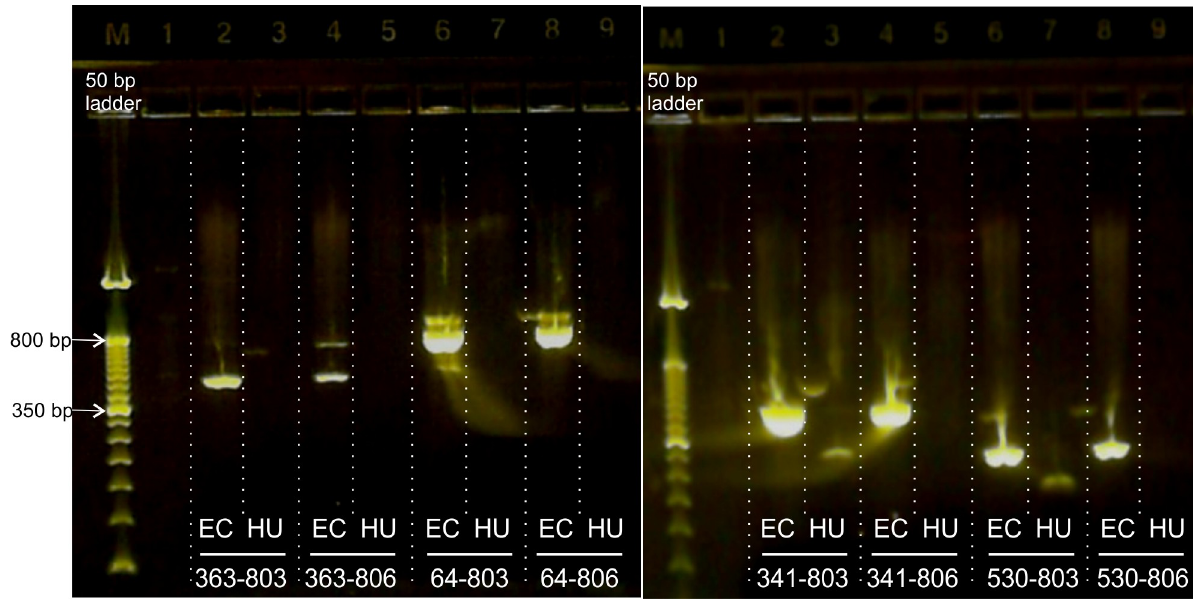
Fig 1. Gel electrophoresis on a 2% agarose gel shows amplification of E . coli (EC) and human genomic DNA (HU) with selected primer pairs. The 341–803 and 530–803 primer pairs resulted in misamplifications with human genomic DNA, while the 363–806 primers produced secondary PCR products. All other primer pairs resulted in specific amplification of the 16S rRNA gene. The concentrations of the samples were: 55 ng/ μ l for EC (165 ng total) and 11 ng/ μ l (33 ng total) for HU.